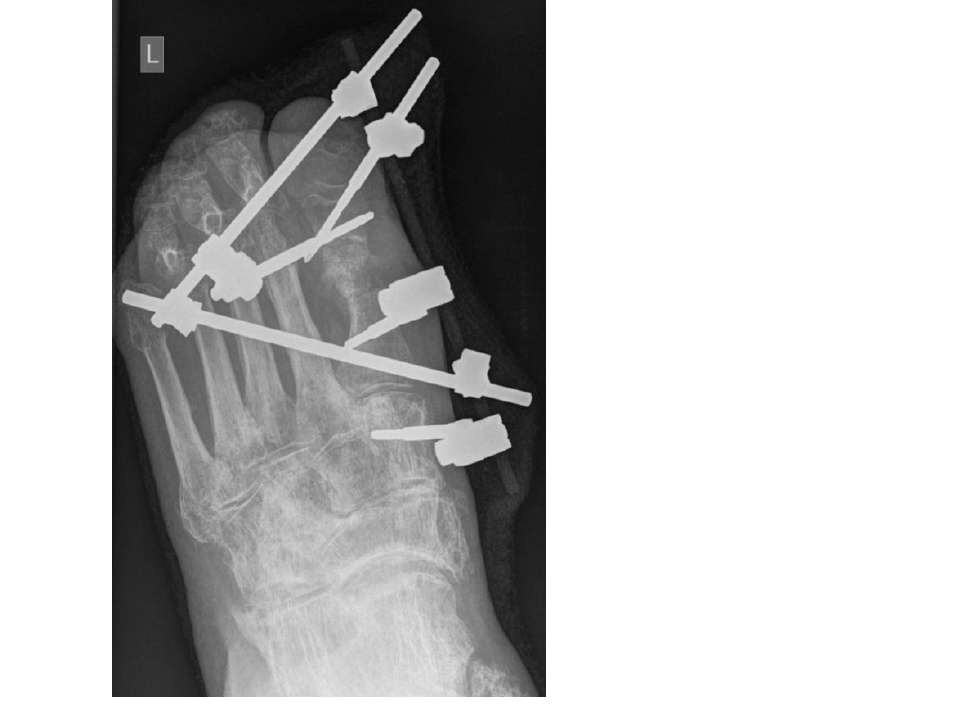
Figure 1. Segmental resection of the first MTP joint with Bioactive Glass S53P4; MTP: metatarsoph- alangeal.